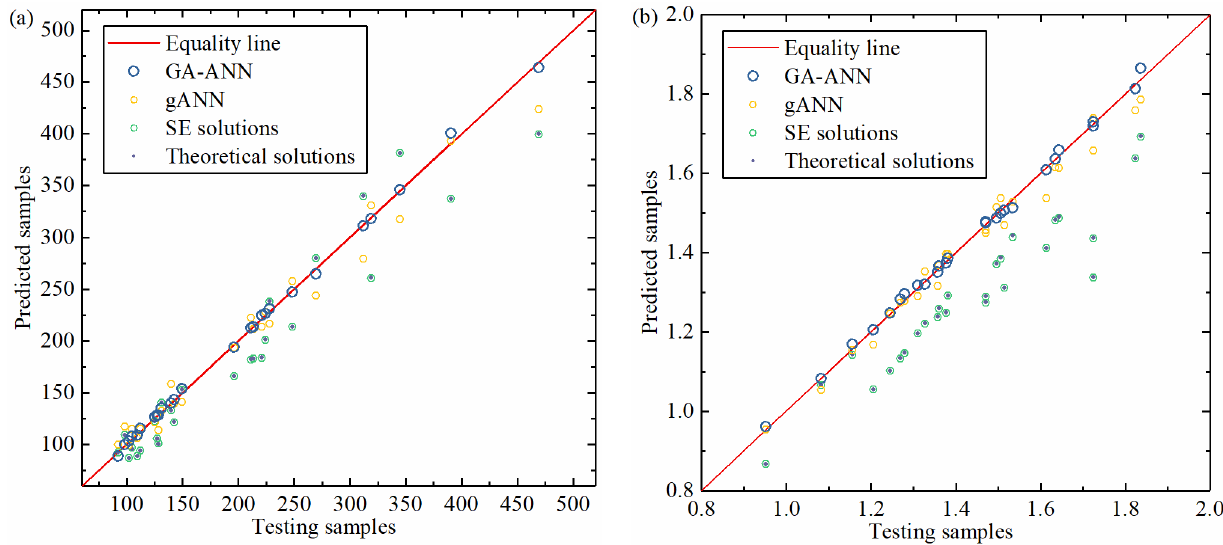
Figure 10. Comparison in regression: ( a ) capillary force and ( b ) contact diameter.